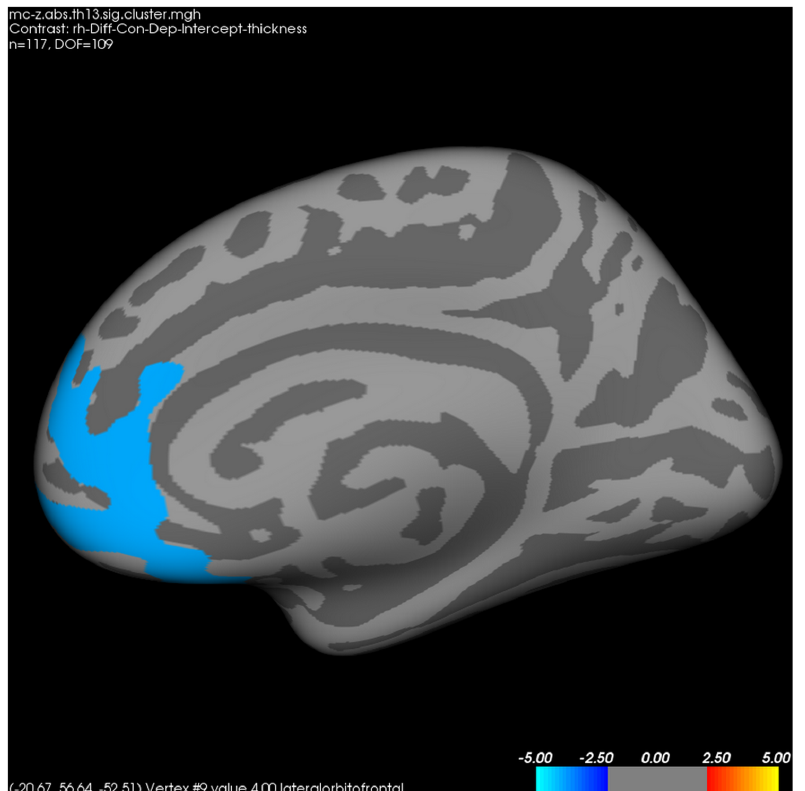
Figure 4. Differences in right cortical thickness between patients with major depressive disorder and healthy controls. FWE -corrected p , 0.05 through Monte-Carlo permutation